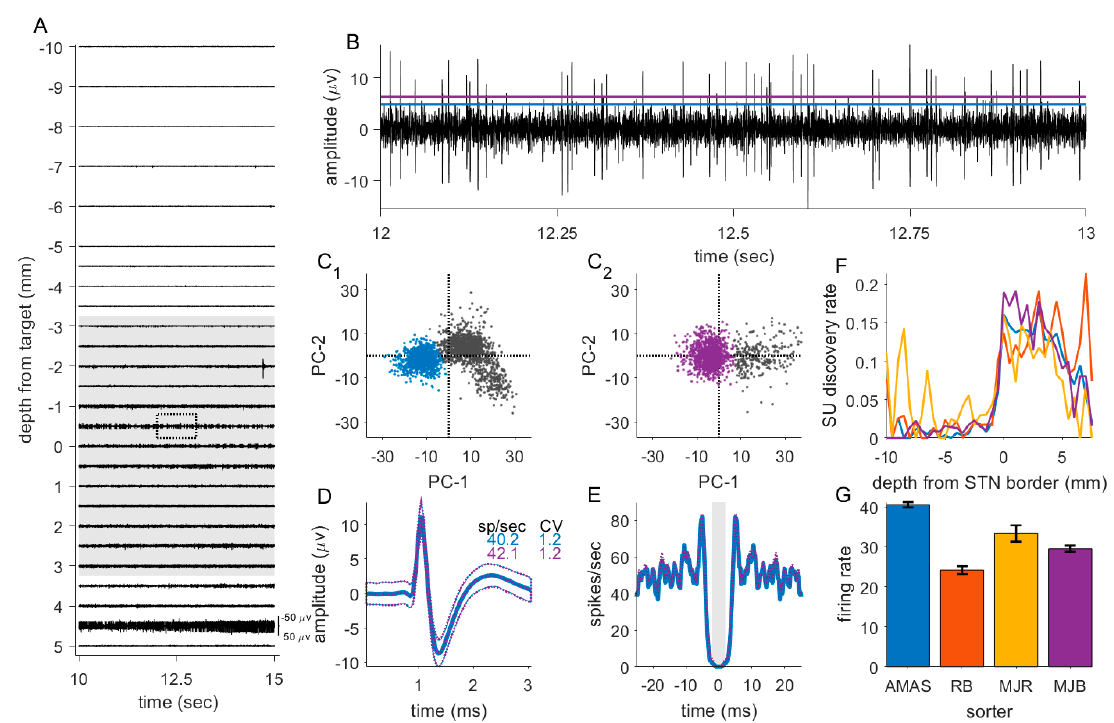
Figure 1. Overview of the sorting process. ( A ) Example recording trajectory of one electrode with 5 s of data shown at each site. Grey shading indicates sites identified as within the subthalamic nucleus (STN). ( B ) Expanded view of data from one recording site (region highlighted by a dashed box in A) with the spike detection threshold set by A.M.A.S. (blue) and M.J.B. (purple); ( C ) clusters of the spike waveforms identified from the example recording by A.M.A.S. and M.J.B.; ( D ) spike waveform (mean: thick lines, thin lines: standard deviation) of the spike sorted from the example recording by A.M.A.S. and M.J.B.; ( E ) Autocorrelation of the spike times from the example recording by A.M.A.S. and M.J.B.; ( F ) The proportion of sites with identified single units (SU)s (discovery rate) was quite similar, indicating that all sorters applied comparable criteria. ( G ) Nevertheless, the mean firing rate of STN neurons differed somewhat between sorters.